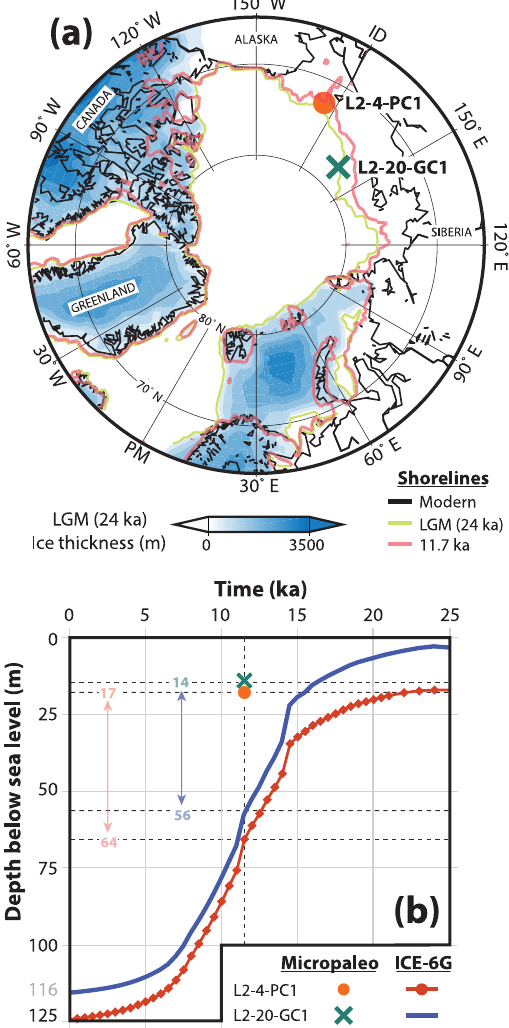
Figure 8. (a) Map showing modern, Younger Dryas, and LGM shorelines based on the ICE-6G model of Peltier et al. (2015). LGM (24ka) ice sheet extent and thickness are designated by blue shad- ing. A green “X” and orange dot mark the locations of core sites 20-GC1 and 4-PC1, respectively. (b) The orange dot and green “X” show paleo-Younger Dryas (about 11.7ka) water depth estimates based on microfaunal assemblages. Expected paleo-water depth his- tories for the 20-GC1 and 4-PC1 sites are given by the blue solid and red dotted line,